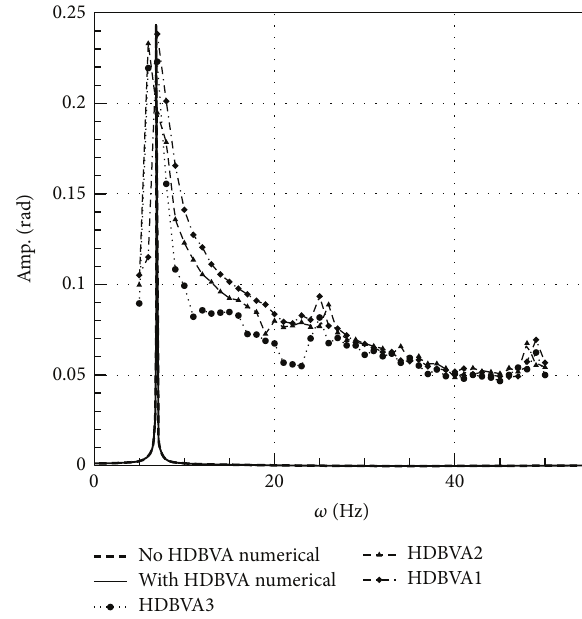
Figure 30: Frequency response of 𝜃 𝑍 DOF of case Figure 10(d), HDBVAs start at the near-force point.